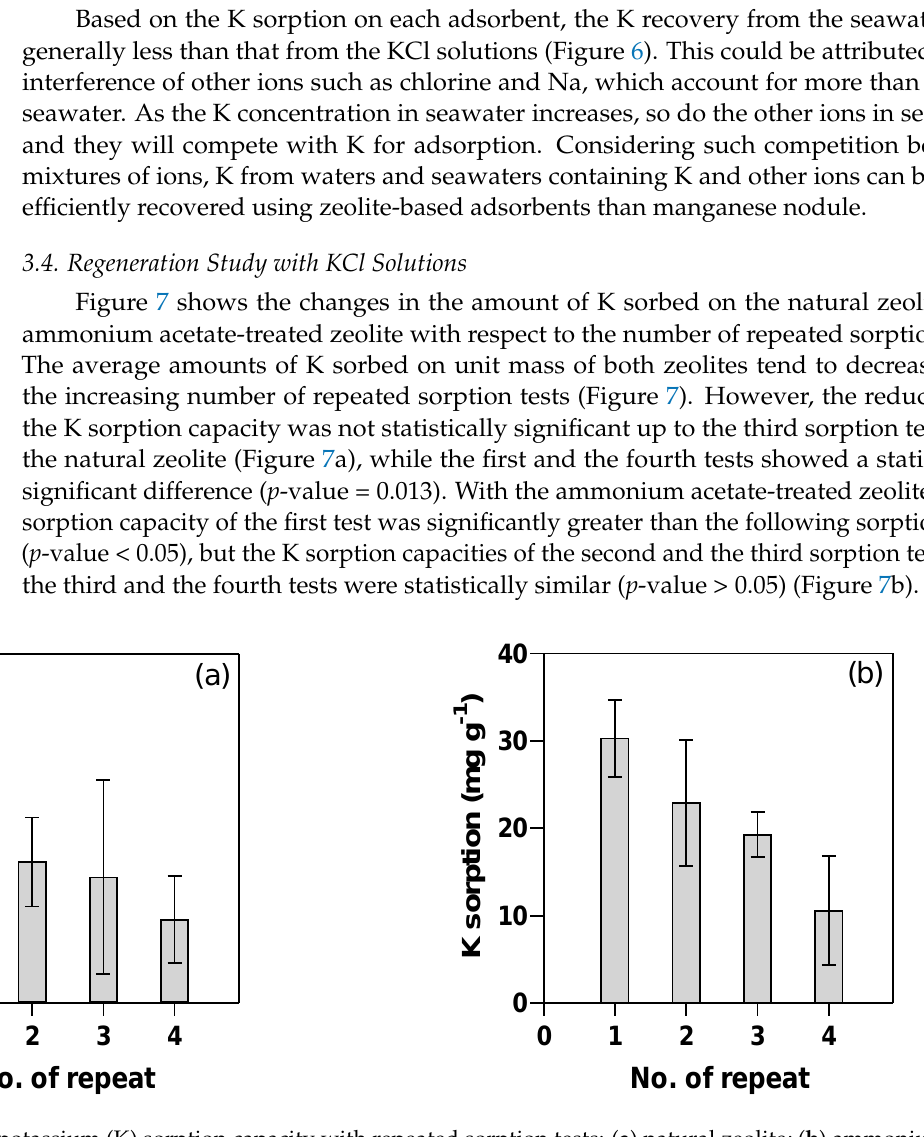
Figure 6. Sorption of potassium (K) on different adsorbents (i.e., natural zeolite (NZ), ammonium acetate-treated zeolite (ATZ), and manganese nodule (MN)) at average K concentration of ( a ) 23 mg L −1 , ( b ) 50 mg L −1 , and ( c ) 120 mg L −1 at KCl pH 4.57, KCl pH 6.99, and seawater pH 8.33. Note that the absence of bar graphs in NZ and MN implies that there was no adsorption to those absorbents.